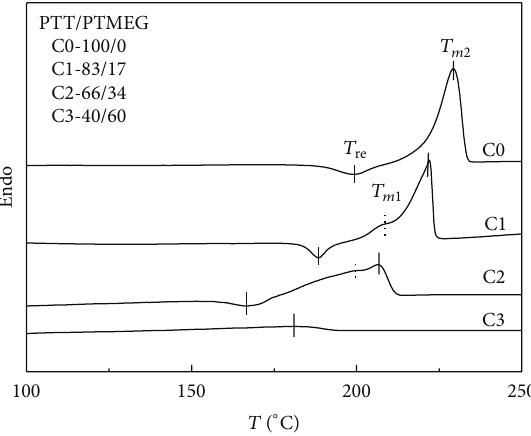
Figure 4: DSC first melting thermograms of the various samples.